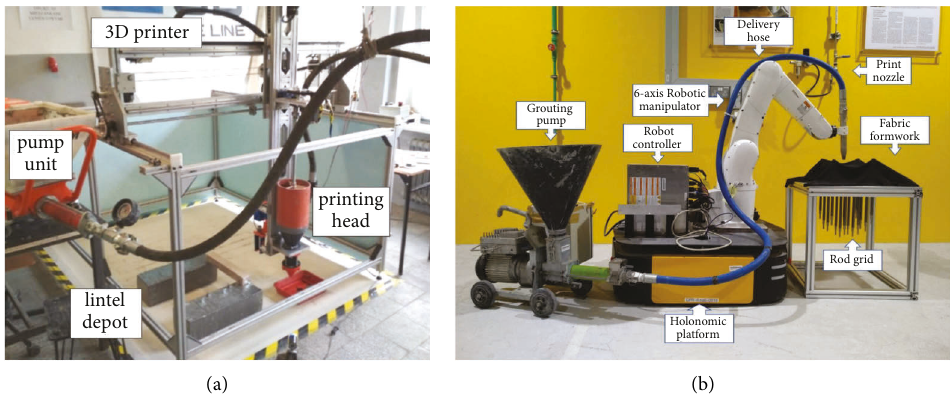
Figure 3: Examples of concrete 3D printing system [11, 12].